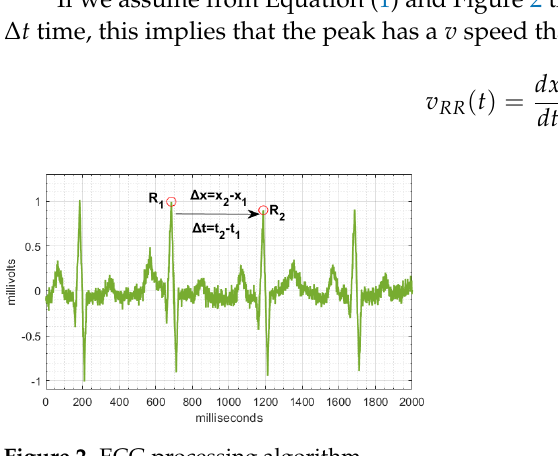
Figure 2. ECG processing